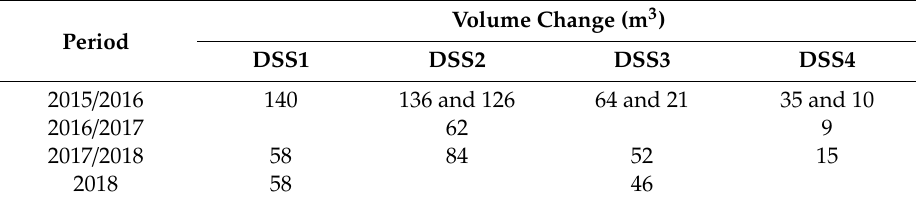
Figure 7. Grain size distributions from samples collected upstream of pits at DSS3 and DSS4. Table 4. Pit volume change between consecutive surveys.